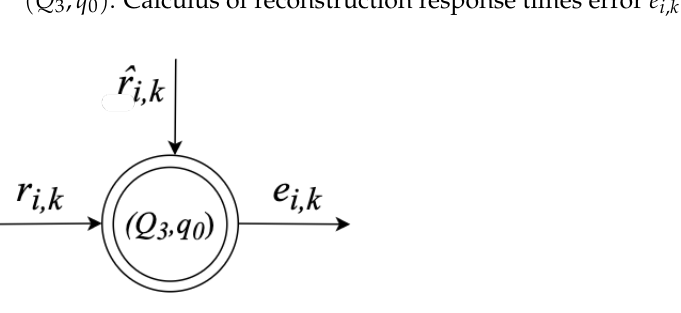
Figure 7. States diagram Q 3 for response times reconstruction error of a task with high priority over RT-Linux.